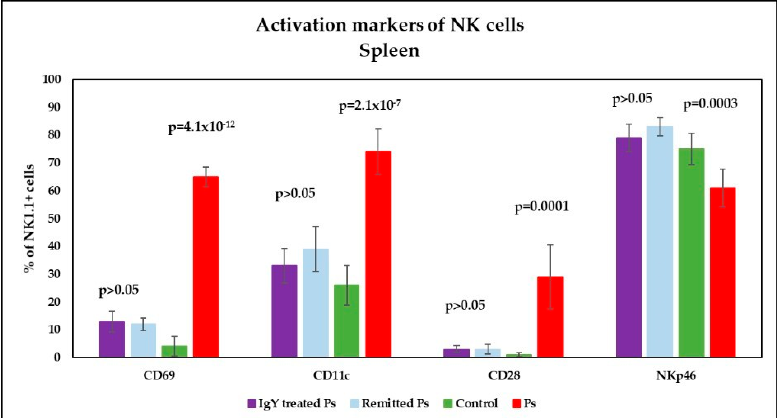
Figure 10. Expression of activation markers on NK cells in spleen cell suspensions. Expression of CD69, CD11c, CD28 and NKp46 levels on NK1.1 + cells for IgY - treated Ps group (n = 12) (13 ± 3.8; 33 ± 6.2; 3 ± 1.2; 79 ± 5) as compared to naturally remitted Ps group (n = 8) (12 ± 2.2; 39 ± 8.1; 3 ± 1.8; 83 ± 3.2), control group (n = 8) (4 ± 3.5; 26 ± 7.1; 1 ± 0.7; 75 ± 5.7) and Ps group (n = 8) (65 ± 3.5; 74 ± 8.2; 29 ± 11.5; 61 ± 6.8). The results (% of NK1.1 + cells) are presented as mean ± SD; n = number of mice).